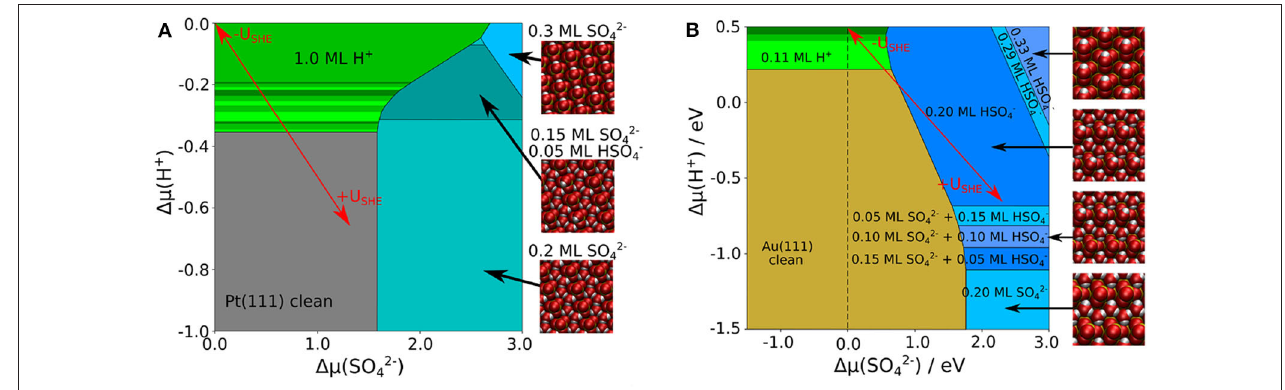
FIGURE 4 | Phase diagram of co-adsorbed sulfate, bisulfate, and water on Pt(111) (A) and Au(111) (B) , including a combination of implicit and explicit solvent. The uncovered metal electrodes are indicated in gray [Pt(111)] or in brown [Au(111)], respectively; green: pure hydrogen coverage; blue: pure 0.3ML sulfate or bisulfate coverages; cyan: sulfate or bisulfate row structures in 0.2ML coverage with additional 0.4ML explicit